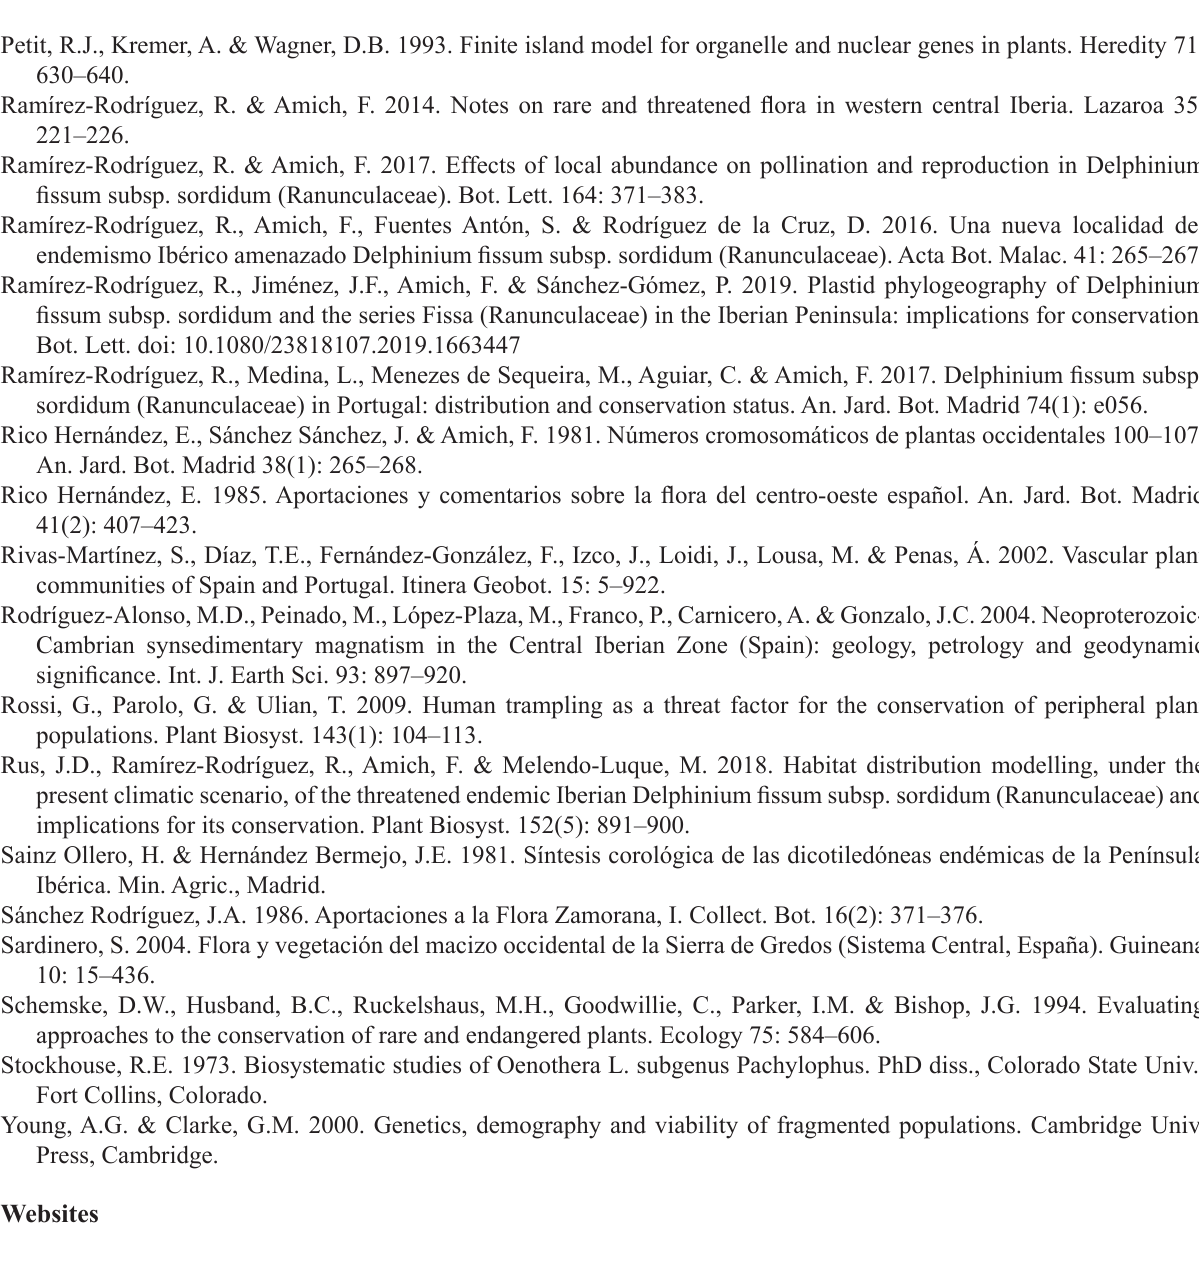
Table S1. Relevés recorded in the localities where Delphinium fissum subsp. sordidum was